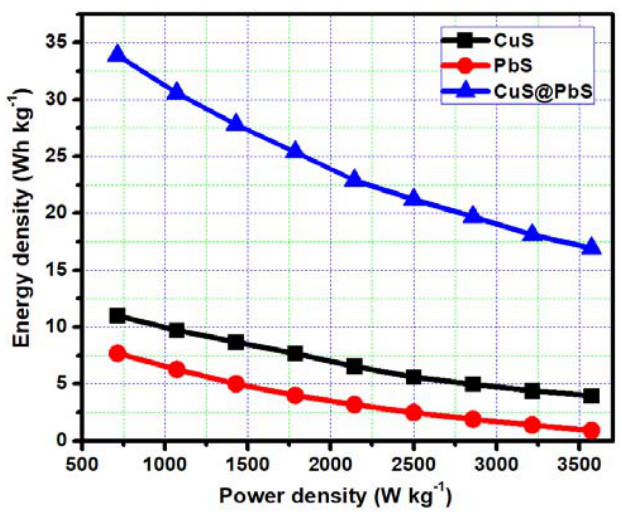
Figure 7. Impedance Nyquist plots of the CuS, PbS and CuS@PbS electrodes.